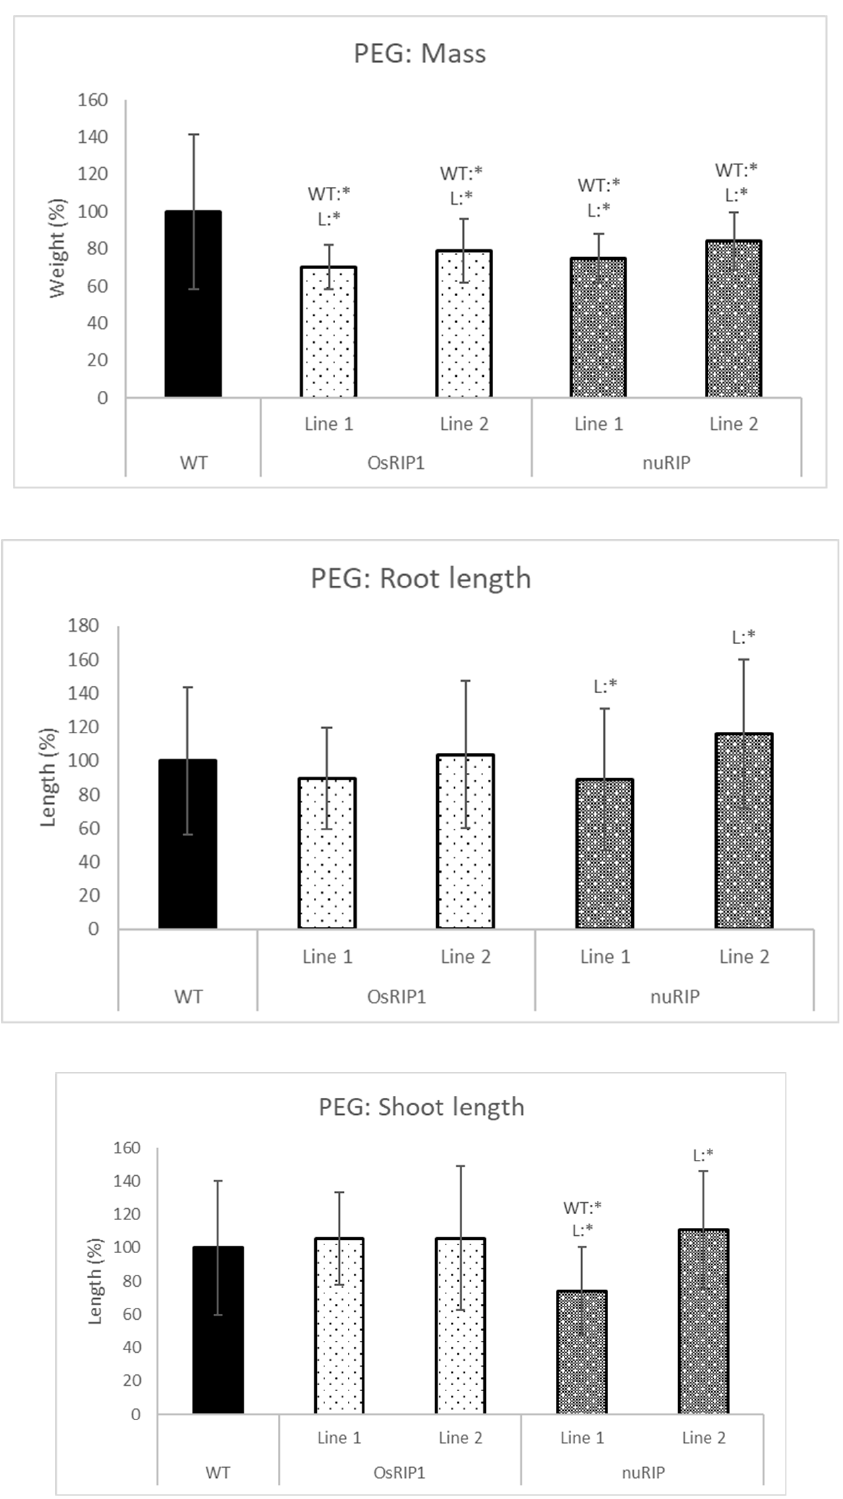
Figure 9. Total mass, shoot and root length of one-week-old plants from different transgenic lines subjected to 20% PEG-6000 compared to those of wild-type. WT:* refers to a significant difference to wild-type plants. L:* indicates a significant difference to the other transgenic line of the same construct. The histogram is based on averages; error bars represent the standard deviation. Each data point is gathered from 50 plants per line.